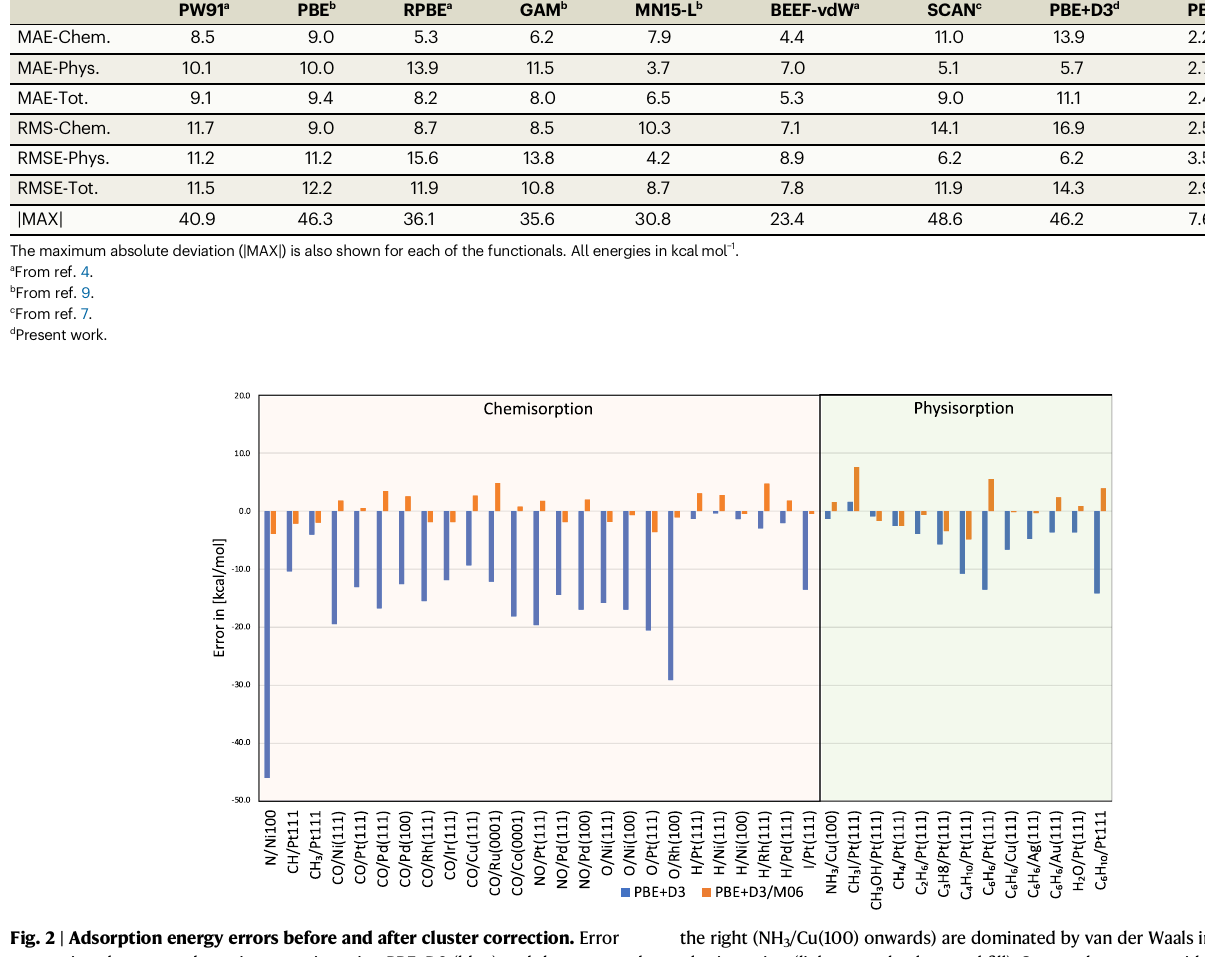
the right (NH 3 /Cu(100) onwards) are dominated by van der Waals interactions — physisorption (light green background fi ll). Source data are provided as Source data fi